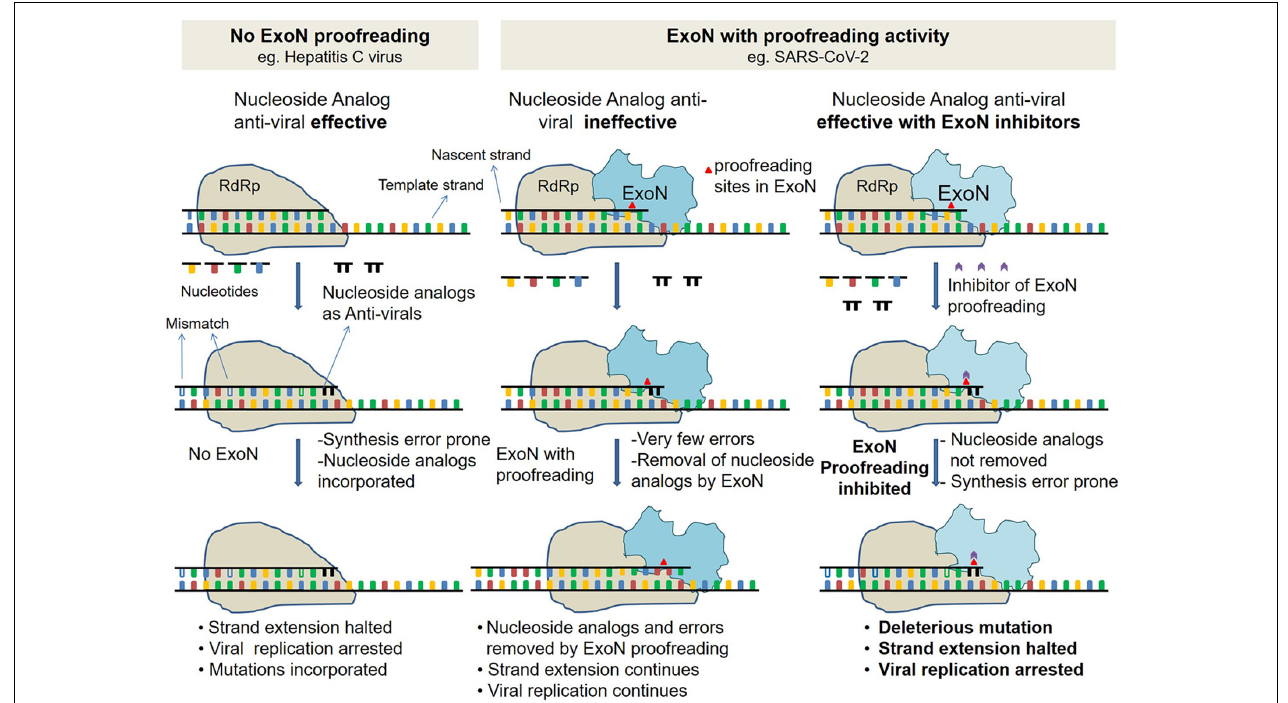
FIGURE 1 | Schematic describing ExoN proofreading activity and mode of action of inhibitors. (Left) Replication in viruses such as hepatitis C virus (HCV), with no proofreading mechanism. Replication by low fidelity RNA-dependent RNA polymerase (RdRp) in absence of ExoN is error-prone. Incorporated nucleoside analogs (NAs) are not excised, resulting in either premature replication termination or incorporation of mutation. (Middle) Replication in viruses such as SARS-CoV with proofreading exonuclease (ExoN). Like HCV, in SARS-CoV-2 too, replication is by low-fidelity RdRp, but errors and NA are excised by proofreading ExoN, and decreasing the efficacy of antivirals. (Right) Same as middle panel but in presence of ExoN inhibitor. In presence of ExoN inhibitor, NA might not be excised, and resulting in premature replication termination.